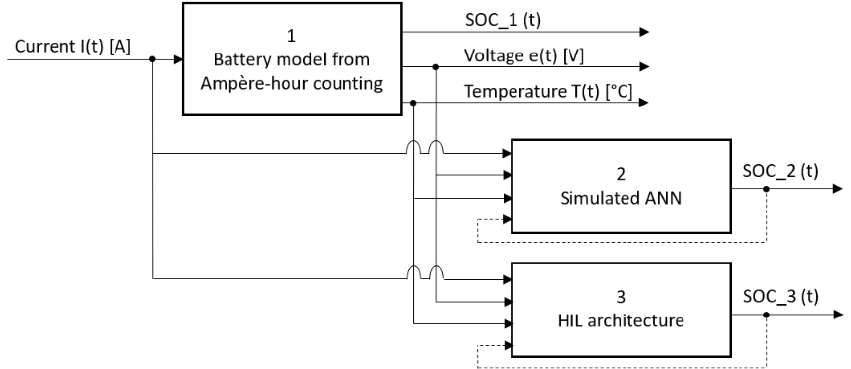
Figure 1. Layout of the training, test and validation setup: 1: Reference model obtained with Ampère-hour counting method in a laboratory environment. 2: ANN simulated in Matlab/Simulink environment. 3: Hardware in the Loop test with the ANN deployed on an electronic control unit in serial communication with a computer.